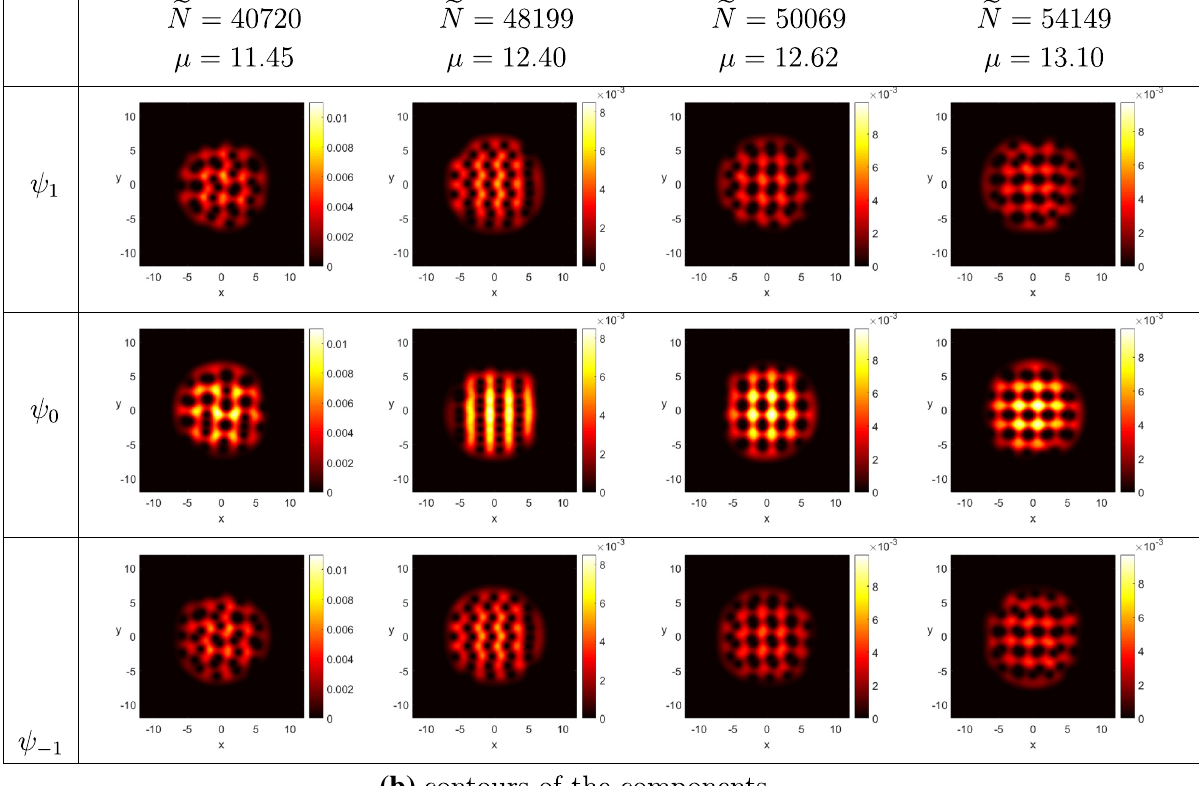
0.01 , M 0 , ω 0.8 , and N = = =